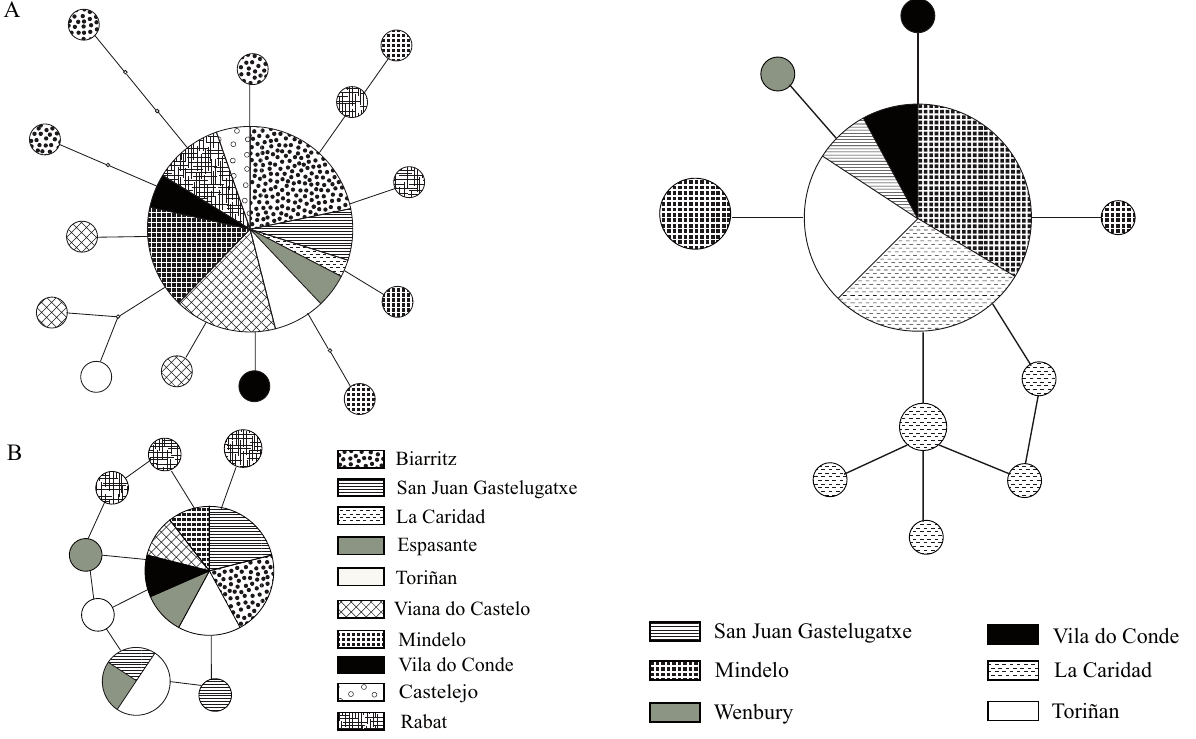
Fig . 2. – A) Mitochondrial (COI) haplotype network of S. lancifer; Fig . 3. – Mitochondrial (COI) haplotype network of S. acuminatum. B) Nuclear (EF1 α ) haplotype network of S. lancifer. Circles are Circles are proportional to the number of haplotypes and localities proportional to the number of haplotypes and localities are coded are coded by filling pattern. Each branch connecting haplotypes by filling patterns. Each branch connecting haplotypes represents represents one nucleotide one nucleotide substitution. The smallest open circles represent unobserved haplotypes.